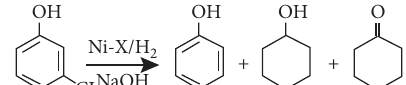
the case of Ni-TiO , and the conversion was up to 95.3% 2 within 90 min. Besides, Ni-VPO catalyst illustrated the high activity to the hydrodechlorination as well, even though it is